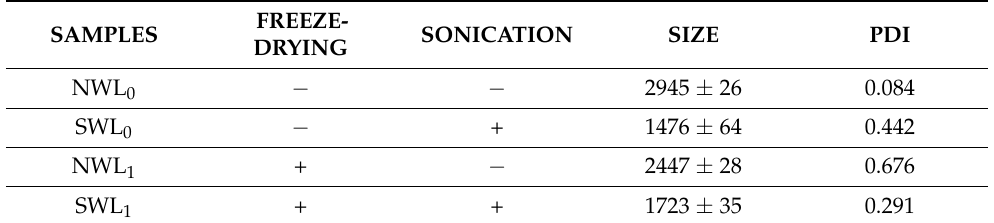
Table 6. Different size measured at the DLS between yeast cells of native, sonicated and lyophilized lees samples.